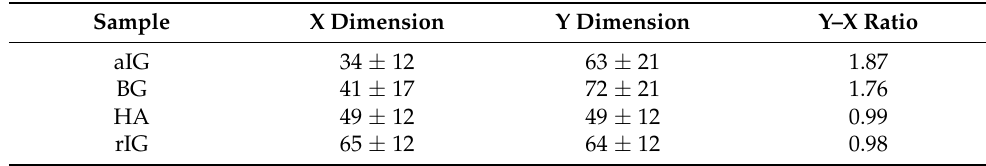
Figure 1. SEM images of the used filler particles; ( a ): angular inert glass, ( b ): round inert glass, ( c ): angular BG, ( d ): round hydroxyapatite. Scale bar: 100 µm. Red square: zoomed in structure of hydroxyapatite particles, exhibiting a rough surface (not observed on the glass particles). Table 1. Median values with standard deviation and Y–X ratio for the measured filler particles. Values are shown in (µm).